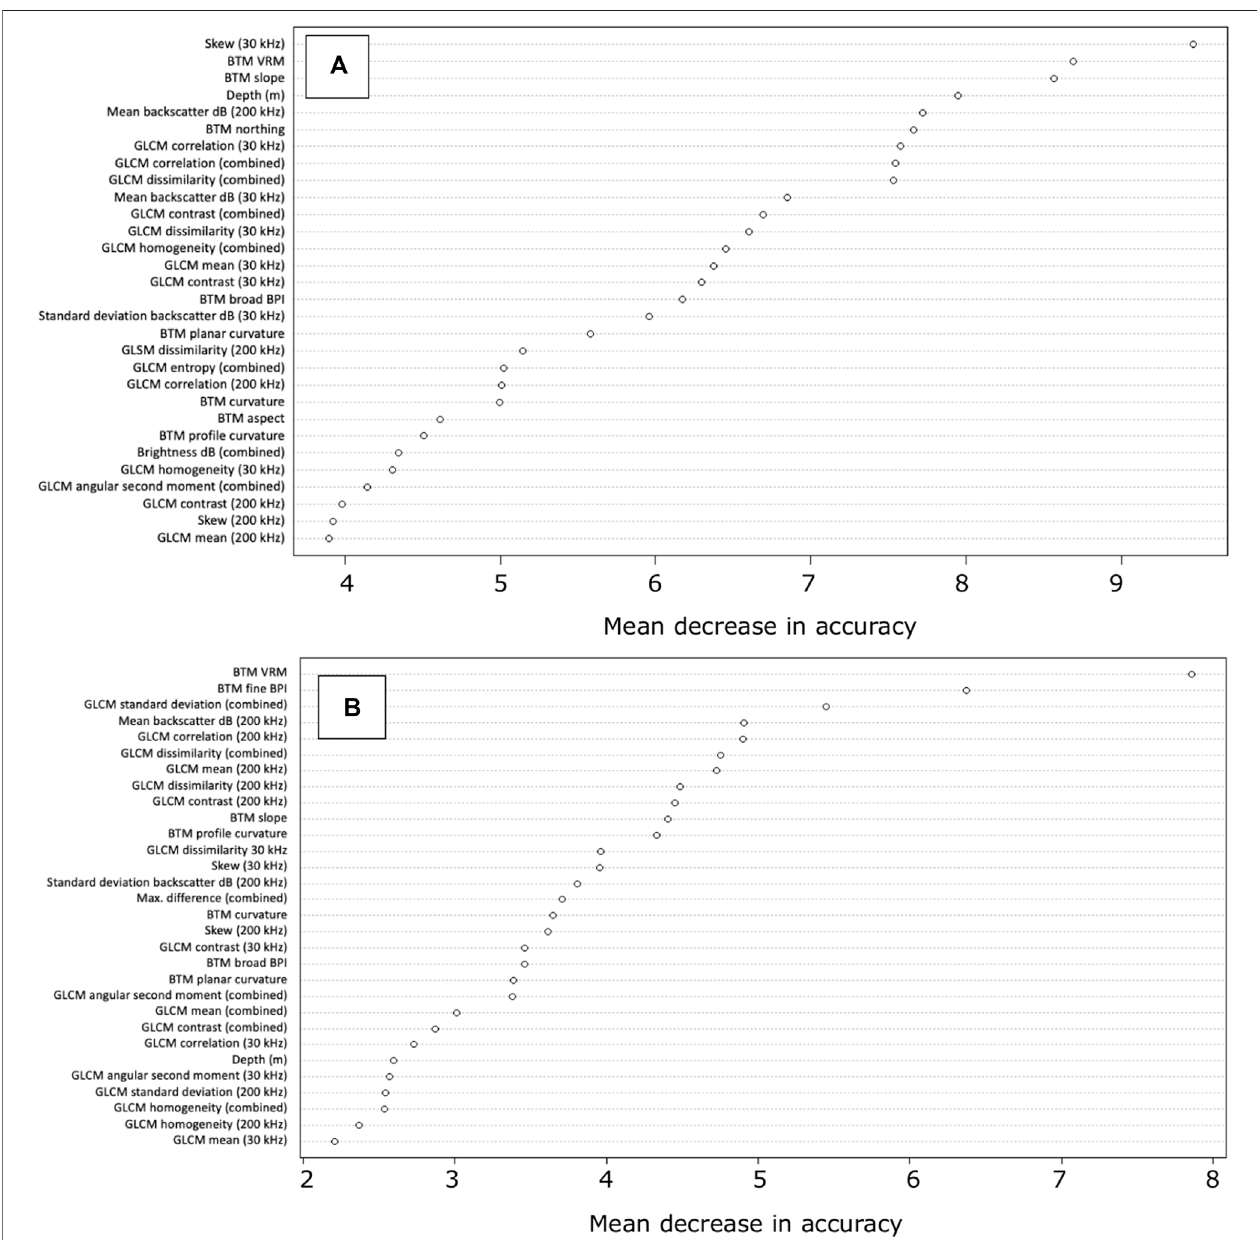
FIGURE7| Variableimportanceplotsofthe “ meandecreaseinaccuracy ” measure. (A) NorthCalypsoHVFbestperformingmodelNCHVF04:combinedmosaics, SP46; (B) South Calypso HVF best performing model SCHVF06: combined mosaics, SP75.